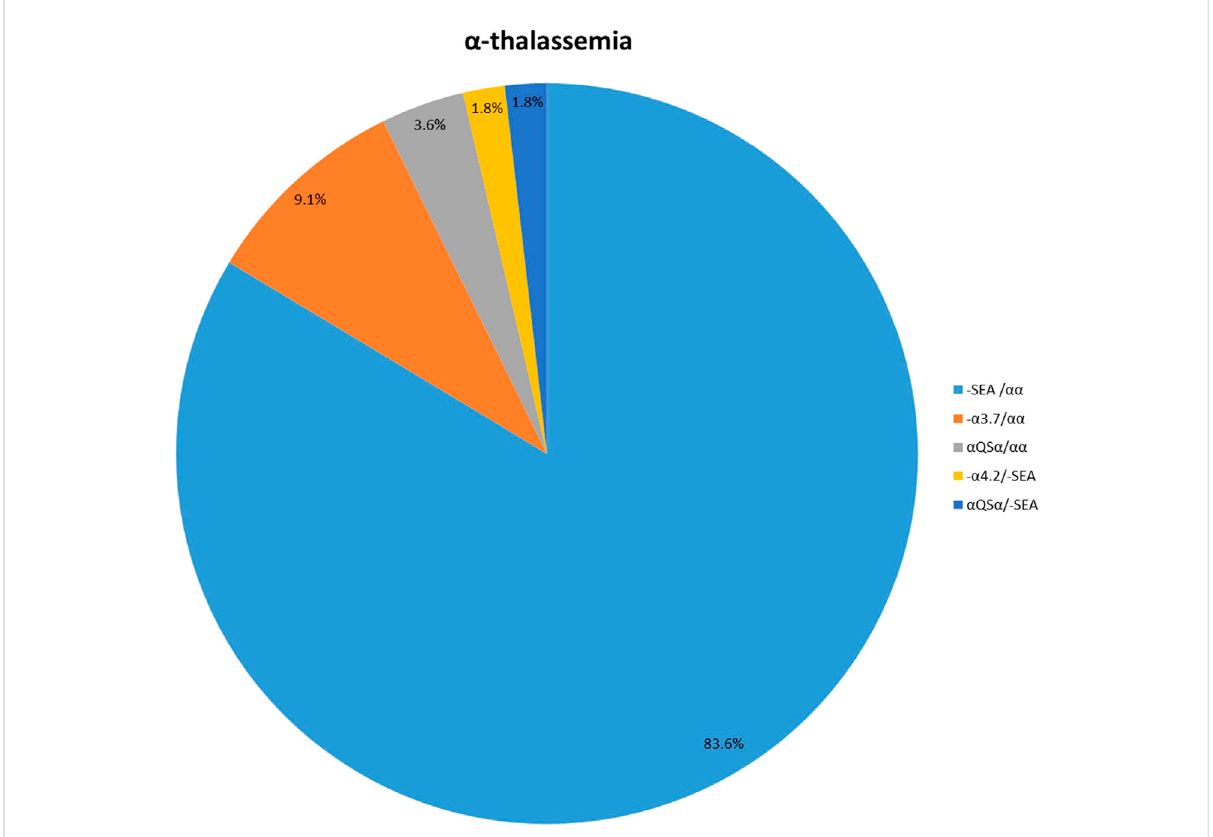
FIGURE 3 The prevalence ofmoleculargeneticsspectrumamong α -thalassemiabreastcancer patientsin Jiangxi province. Themostprevalent genotype of α -thalassemia was - SEA / αα , accounting for 83.6% of all α -thalassemia